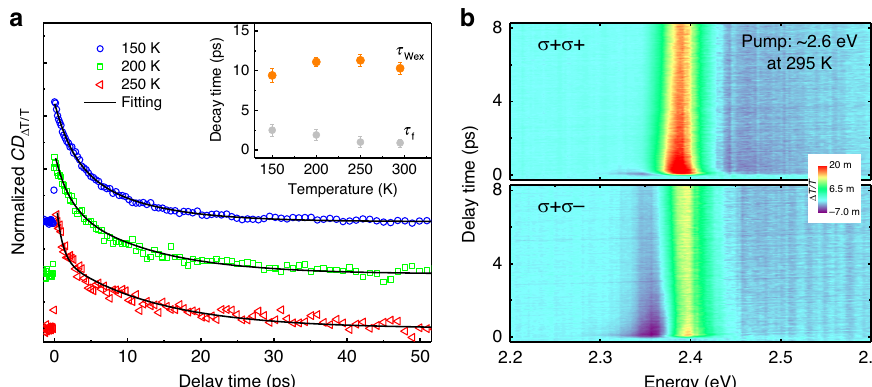
Fig. 4 Temperature and pump-energy dependence of exciton spin dynamics. a Normalized kinetics of CD Δ T / T with vertical offsets as a function of lattice temperature at a fi xed pump fl uence of ~0.2 μ J/cm 2 . The black lines are the fi tting results with bi-exponential decays. The inset shows exciton spin decay times ( τ Wex , orange circles) due to the exchange interaction and the initial fast-decay component ( τ f , gray circles) at different temperature. b Time evolution of σ + σ − and σ + σ − TA spectra under a nonresonant pumping at room temperature. The pump fl uence is ~0.9 μ J/cm